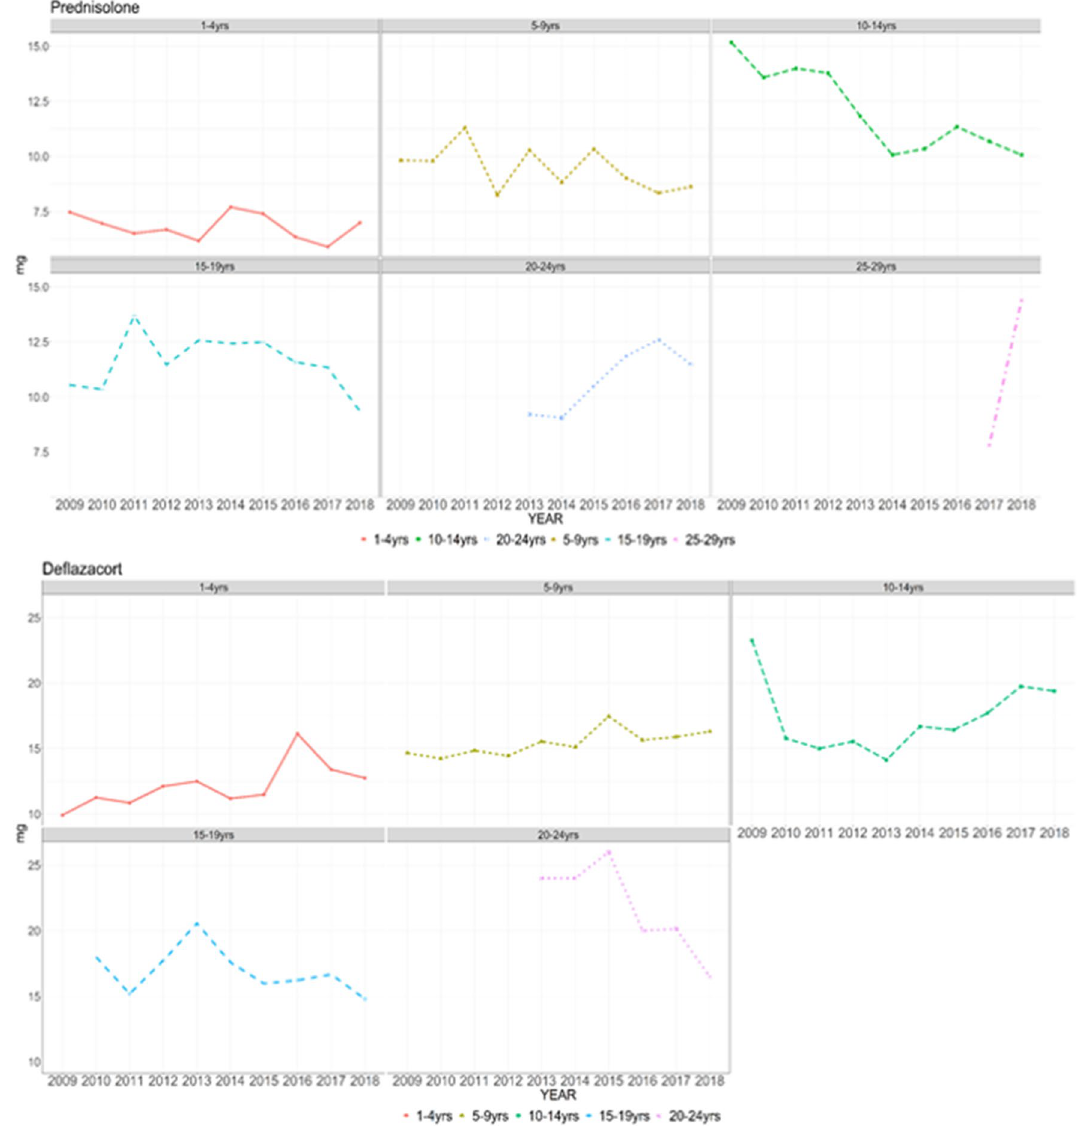
Figure 5. Mean dose of corticosteroid prescription per day in